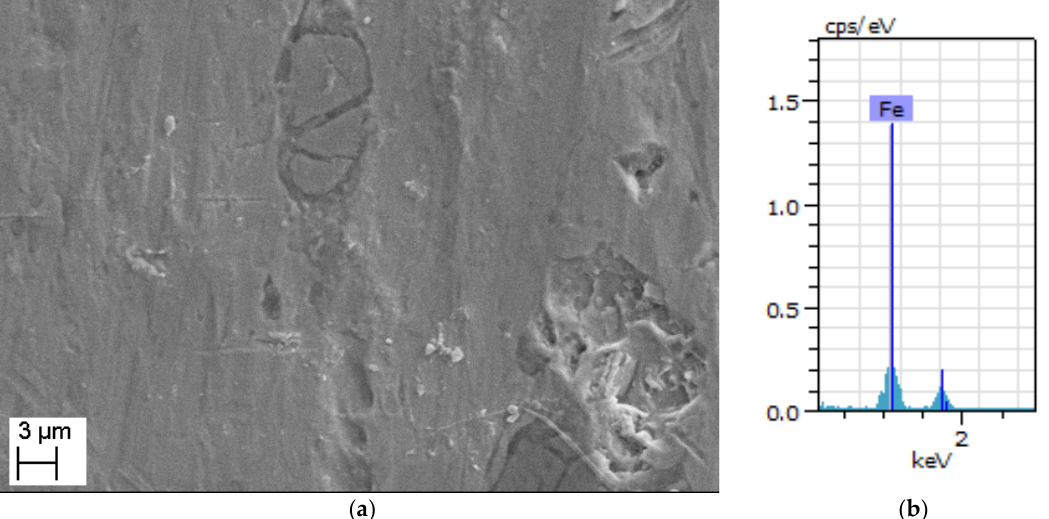
Figure 5. ( a ): SEM image of pure iron after one pass of cold rolling and before annealing. ( b ) EDS analysis of pure iron after one pass of cold rolling and before annealing.